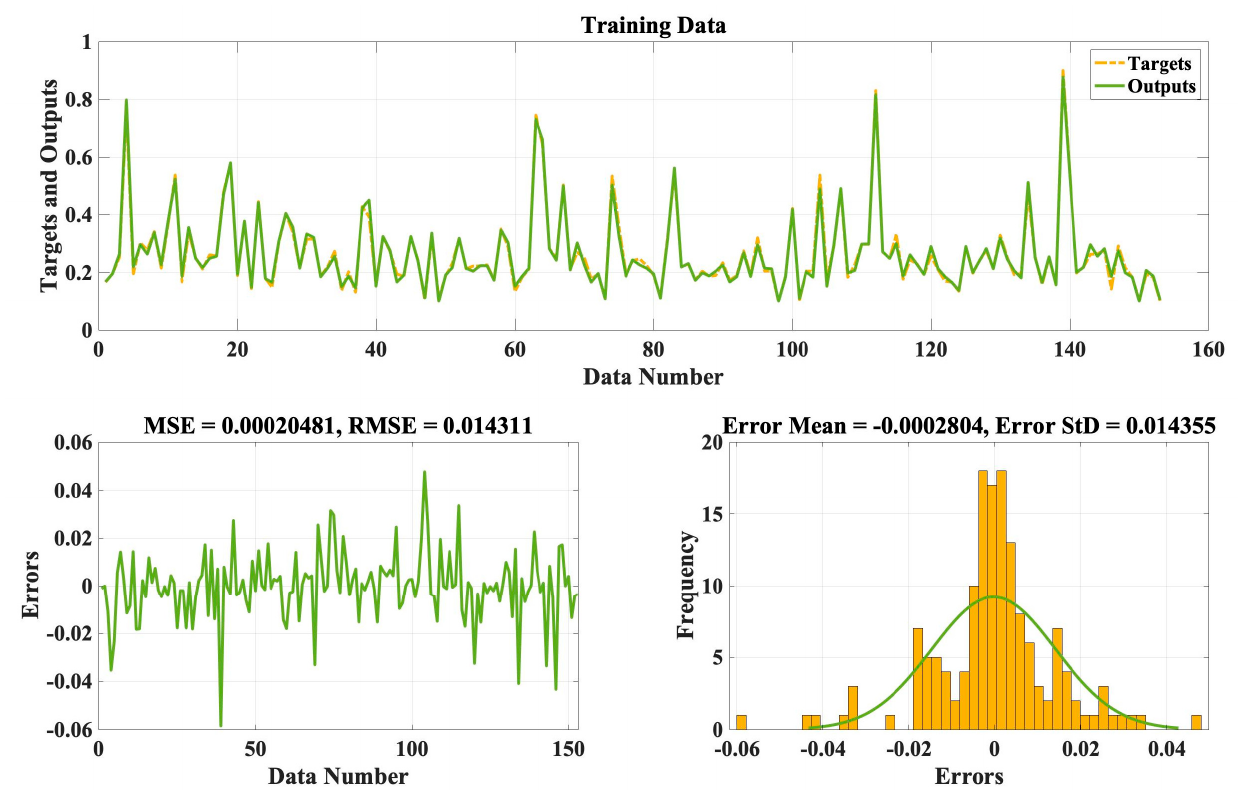
Figure 8. Results of the training data based on normalized values.